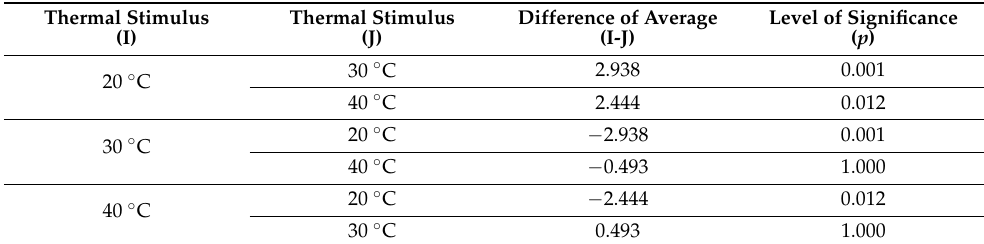
Table 2. Comparison according to the different types of thermal stimuli.